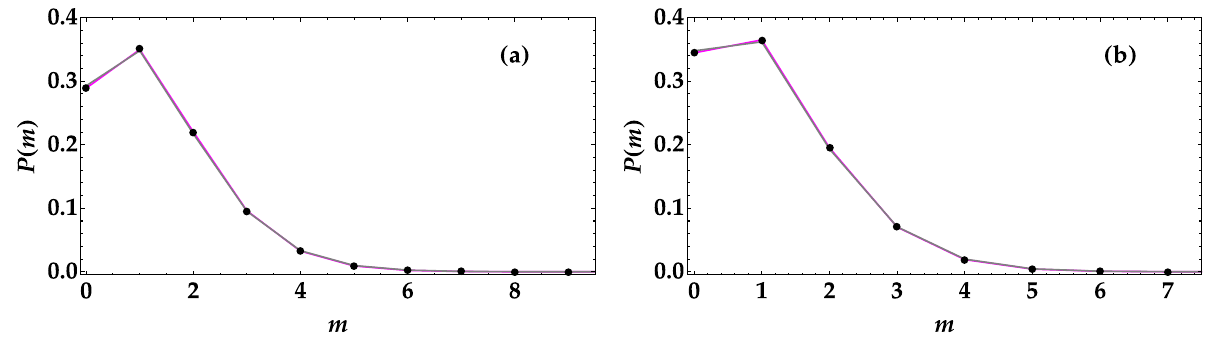
Figure 1. Experimental reconstruction of the distribution of detected photons when a single-mode thermal state is superimposed to a portion of TWB. Black dots: data; magenta curve: fitting function according to Eq. (3); gray curve: fitting function according to Eq. (8). In the left panel the mean value of the state is 1.27 , whereas in the right panel is 1.07 . In both cases the fidelity of data to the two theoretical m m � � = � � = descriptions is very high ( f > 0.9999 ), thus proving that the presence of a small thermal noise signal cannot be simply discriminated by analyzing the